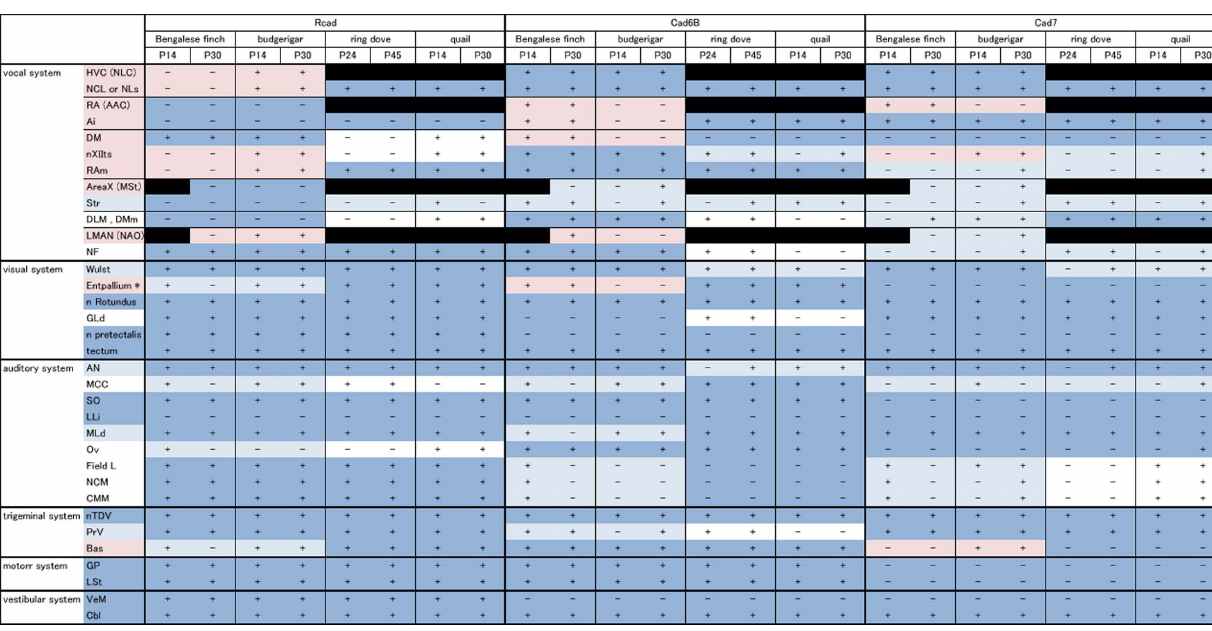
Note that gene expression differed more among species in vocal-related areas than other areas. Dark blue filled region: highly similar expression pattern among species; light blue filled region: similar but developmentally different expression pattern; light red filled region: different expression between vocal learners; white region: different expression between